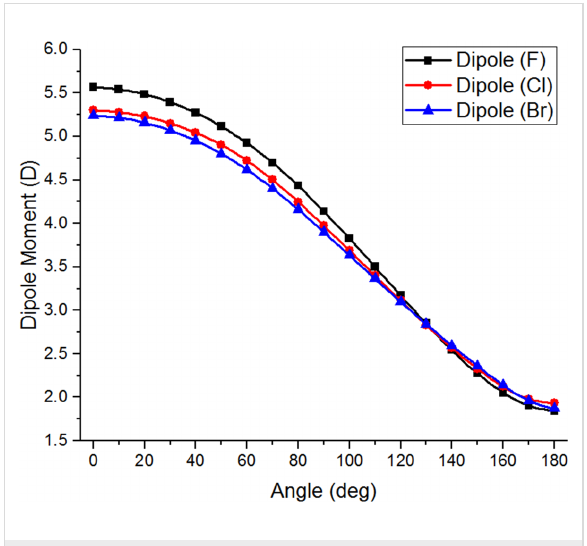
Figure 6: Variation of dipole moment with angle for haloacetophe- nones.